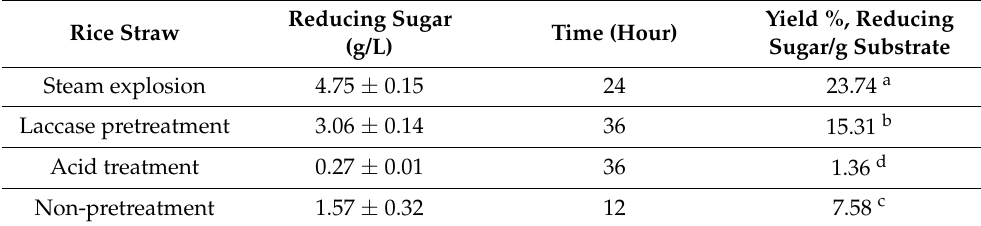
Table 5. Results of steam explosion, acid treatment, and biological treatment.